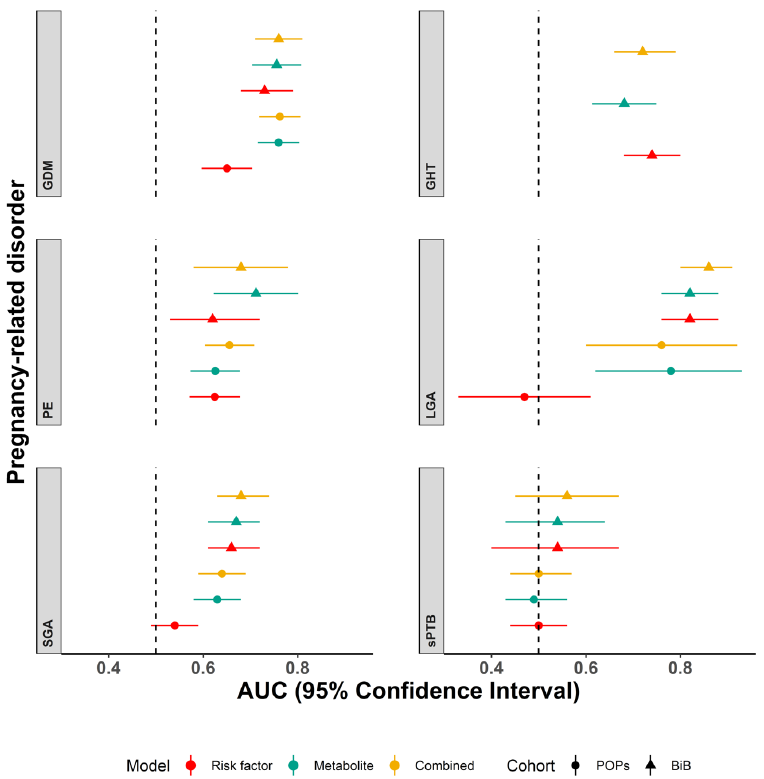
Figure 1. Predictive discrimination of models for each outcome. AUC and 95% confidence intervals are shown for established risk factor prediction models (red), metabolite models (green) and combined risk factor and metabolite models (yellow) trained in the Born in Bradford 2000, tested in the Born in Bradford 1000 (triangles) and externally validated in the Pregnancy Outcome Prediction study (circles). POPs did not have sufficient data on gestational hypertension for validation. Abbreviations: BiB, Born in Bradford; POPs, Pregnancy Outcome Prediction study; GDM, gestational diabetes; GHT, gestational hypertension; PE, pre-eclampsia; SGA, small for gestational age; LGA, large for gestational age; sPTB, spontaneous preterm birth.